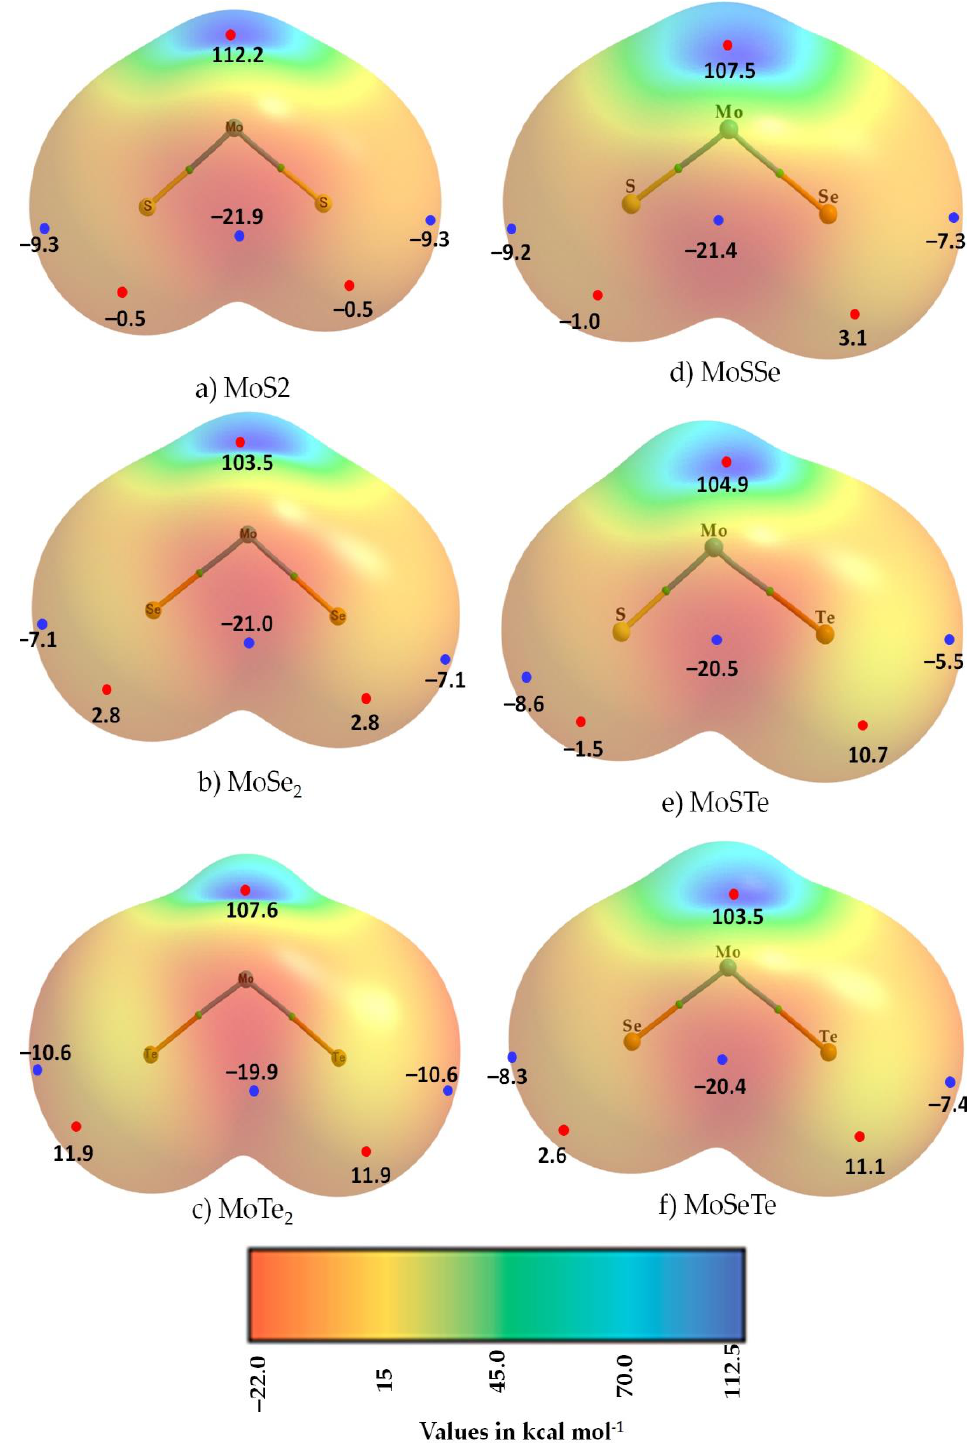
Figure 2. MP2(Full)/Sapporo-TZP-Diffuse computed electrostatic potential surfaces of the six MoCh 2 and MoChCh (cid:48) 2 (Ch, Ch (cid:48) = S, Se, Te) monomers. The 0.0015 a.u. isodensity envelope was used, on which the electrostatic potential was computed. The tiny red and blue circles represent the V S,max and V S,min , respectively. The junction region between the Ch atoms in the monomers was found to be very negative. In all three cases, the charge density profile on the surface of the metal-bonded